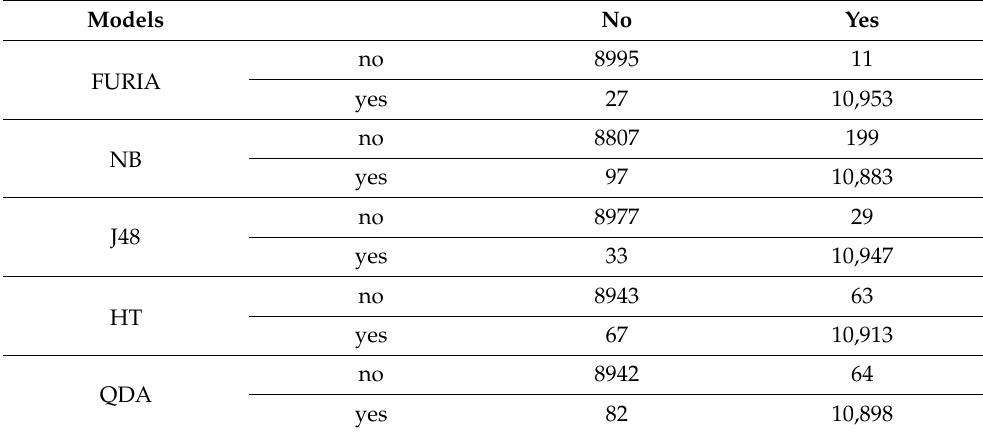
Table 2. Confusion matrix values achieved via each employed model.